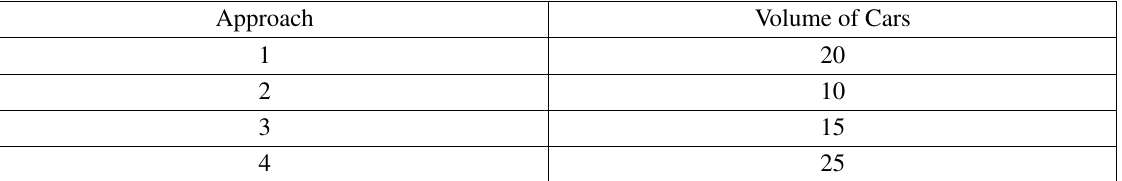
Table 1. Volume of Cars per minute for each approach